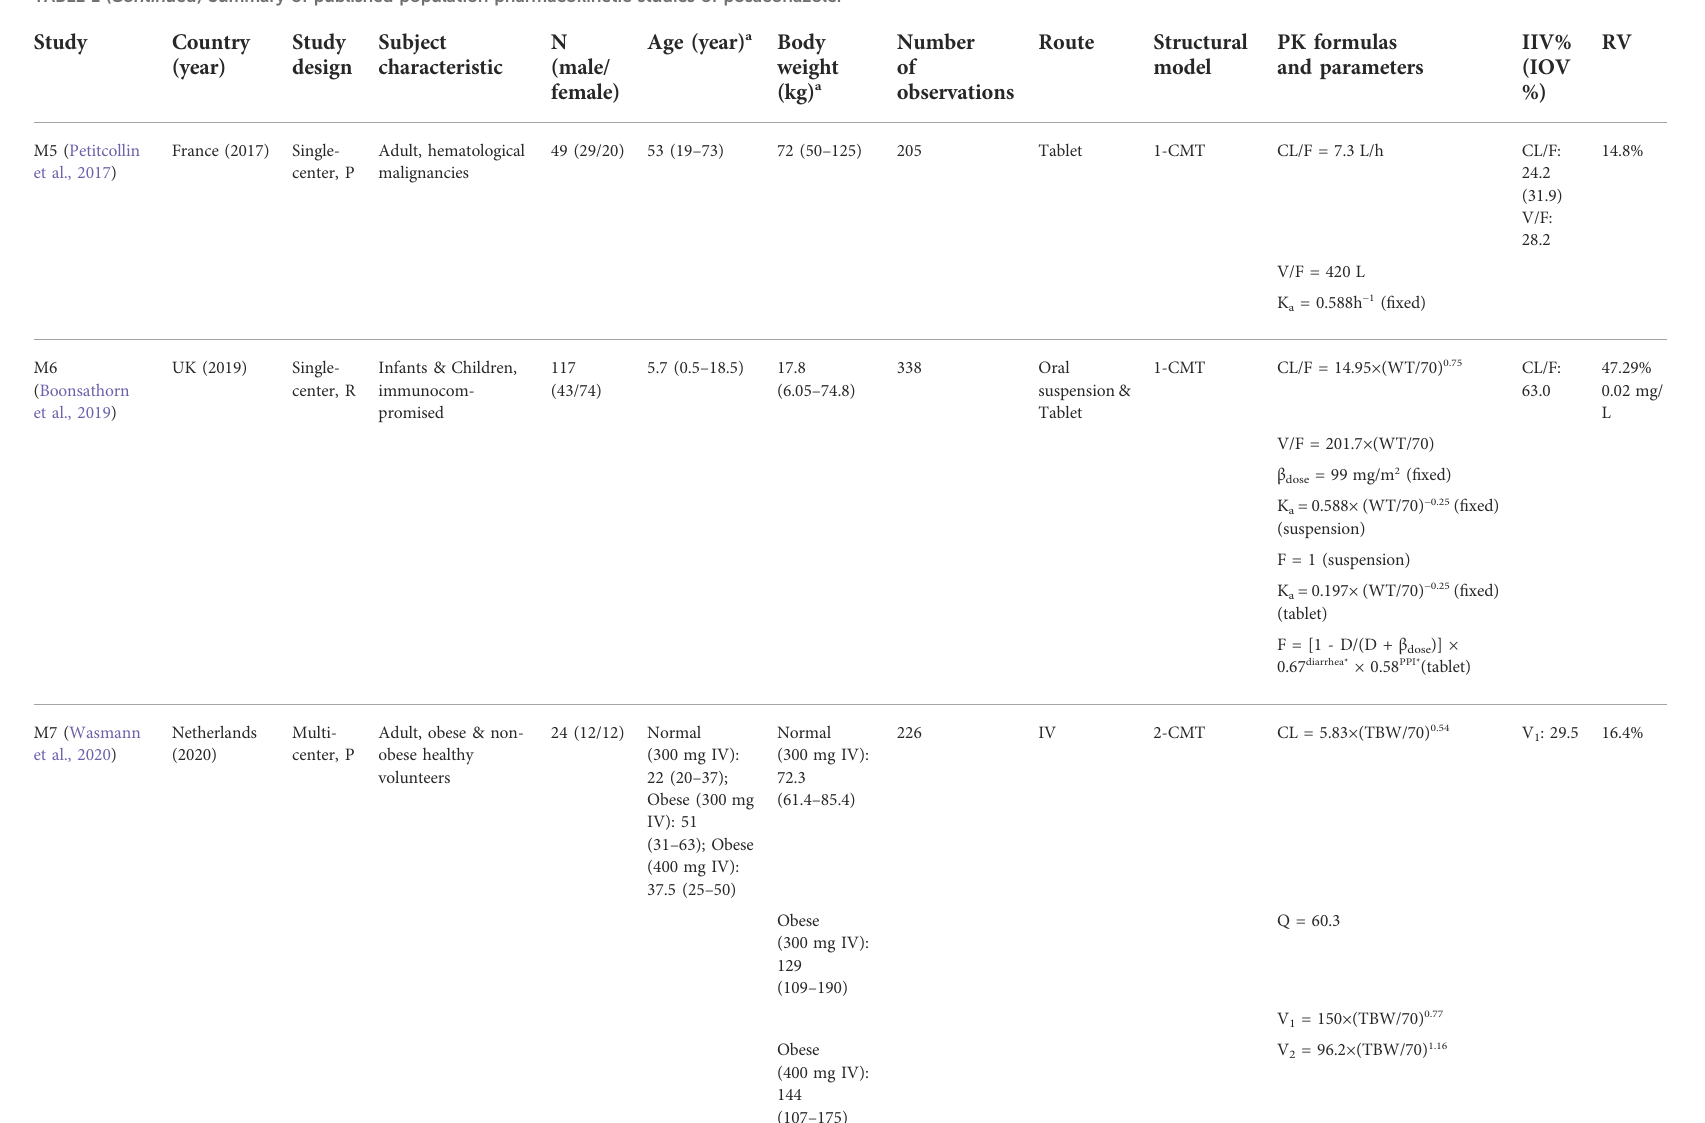
TABLE 1 ( Continued ) Summary of published population pharmacokinetic studies of